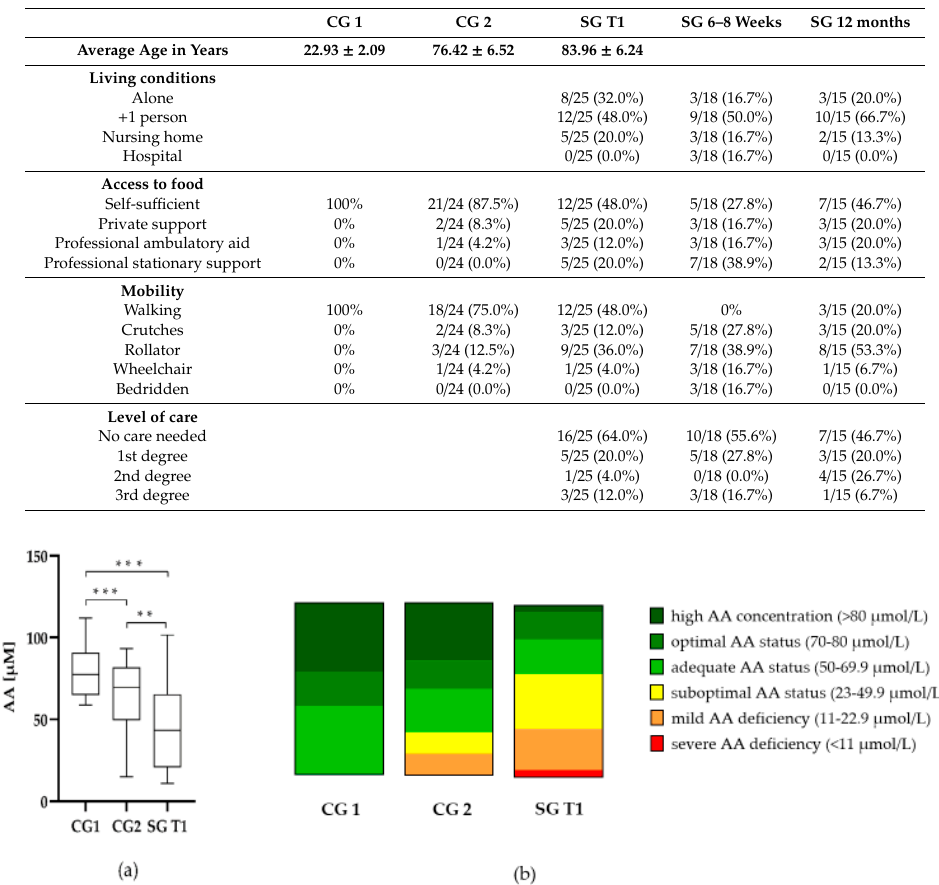
Figure 1. ( a ) AA (ascorbic acid) plasma concentrations and ( b ) AA status of CG1, CG2 and SG at T1